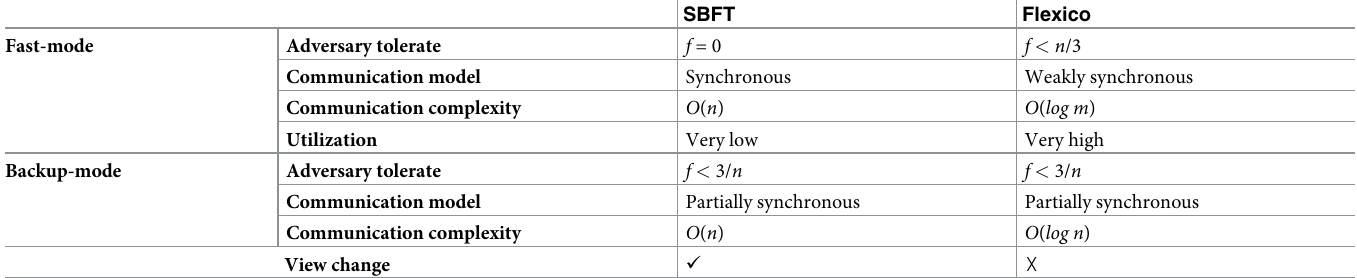
Table 4. Comparison with SBFT